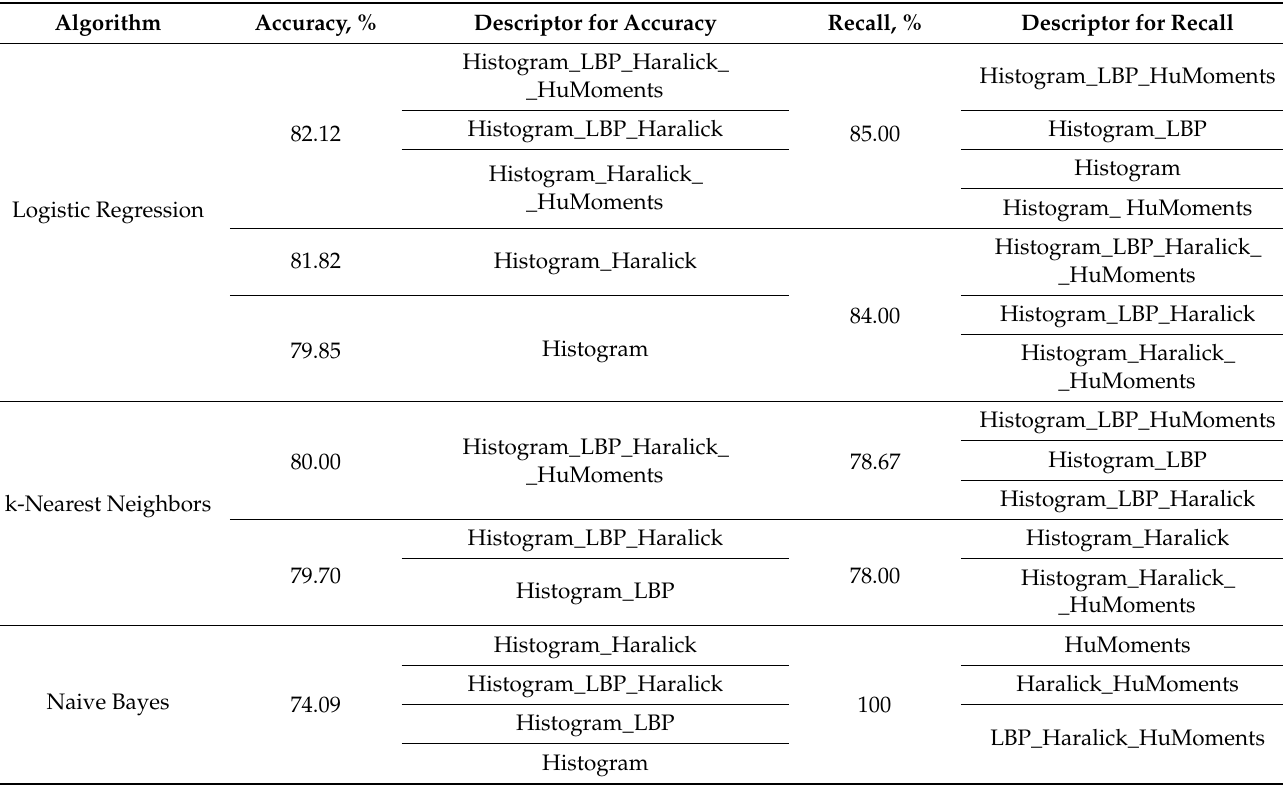
Figure 6. Accuracy and recall of machine learning algorithms. Table 1. Comparison of the obtained results for various machine learning